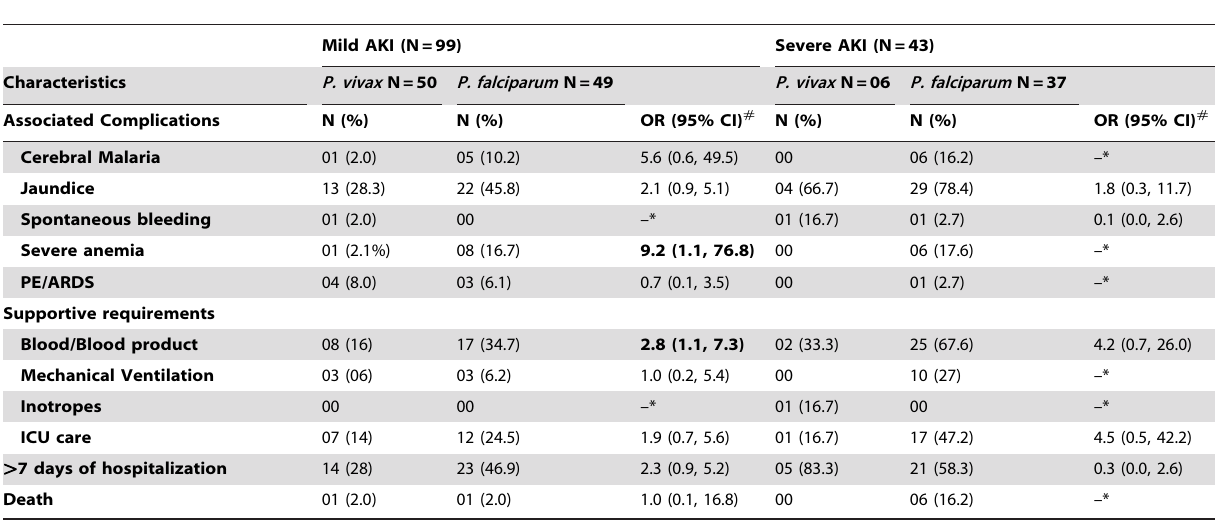
Table 10. Association of AKI, with complications and supportive requirements by malaria